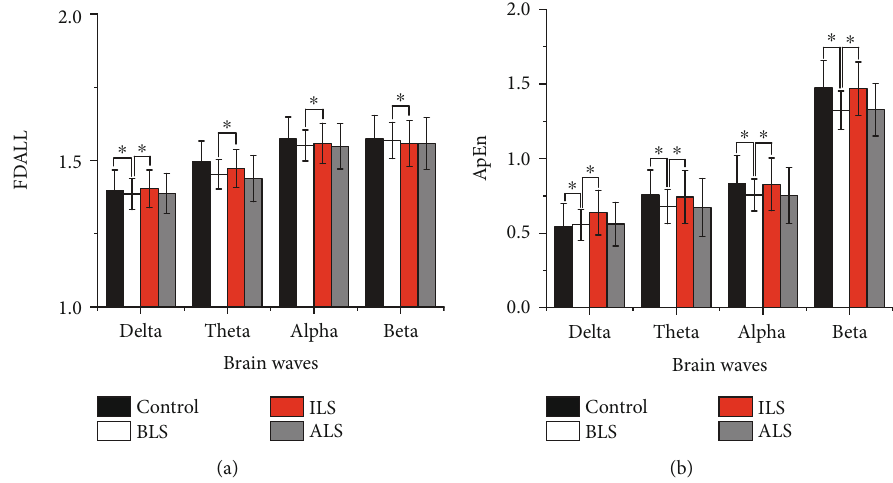
Figure 9: The characteristic value of the LFP signal in the rat globus pallidus brain area after optogenetic experiment. (a) Fractal dimension and (b) approximate entropy. Control represents the LFP signal of rats in the control group; BLS represents the LFP signal before light stimulation in rotenone-treated rats; ILS represents the LFP signal during light stimulation in rotenone-treated rats; ALS represents light in rotenone-treated rat LFP signal after